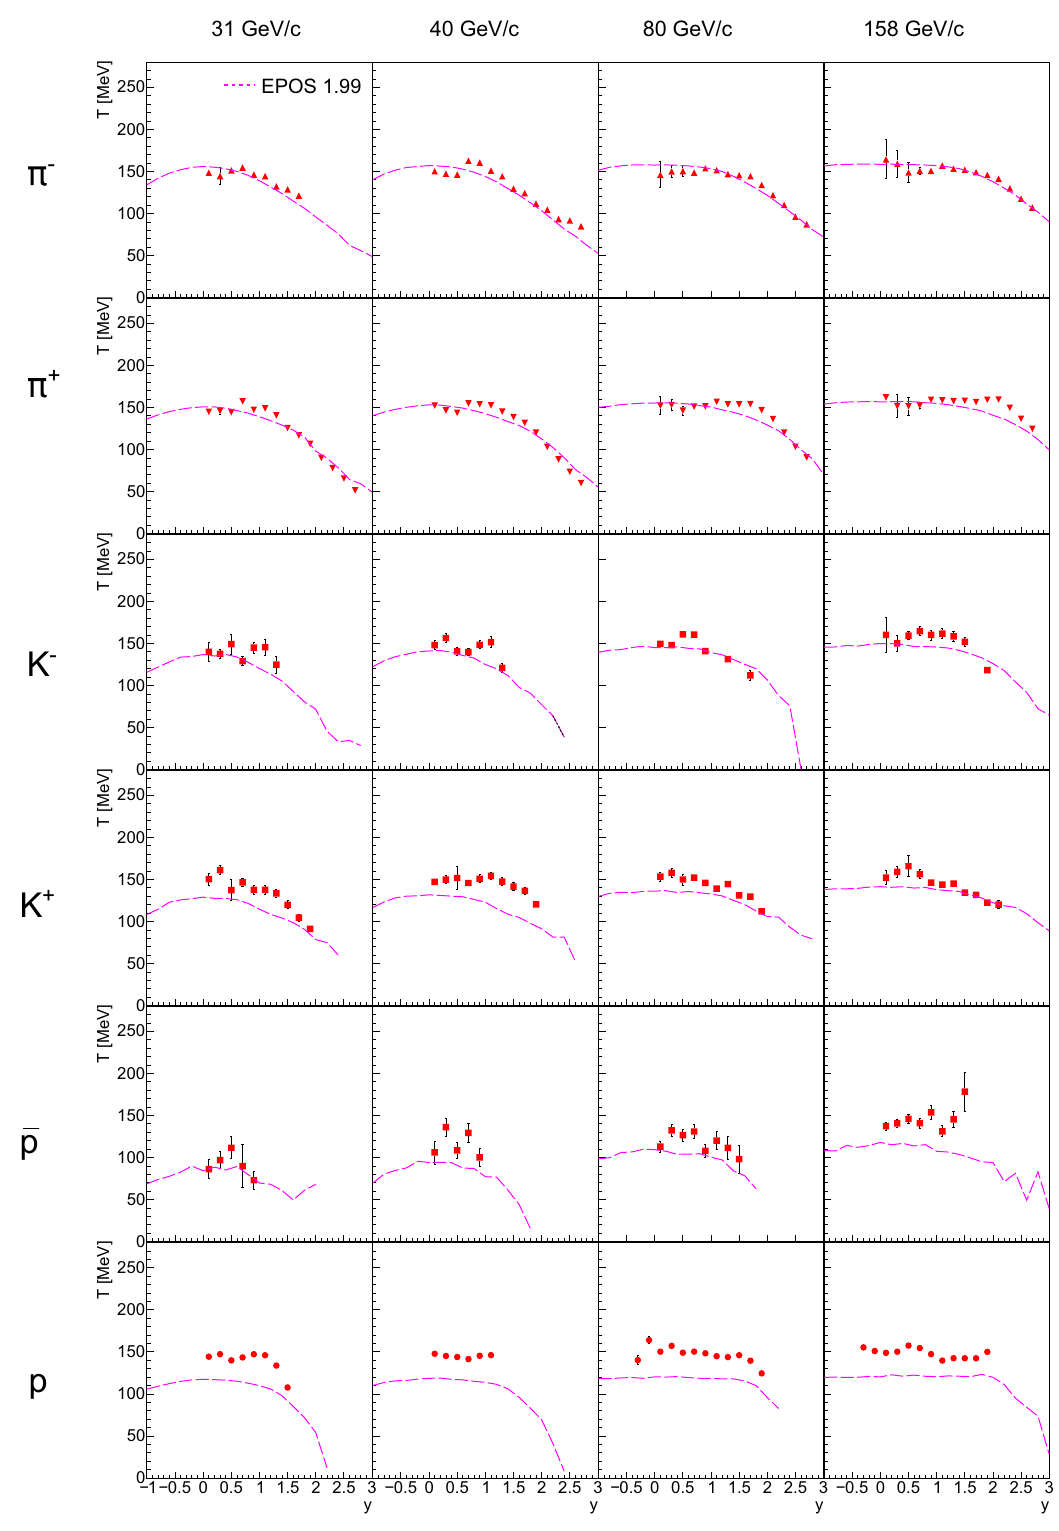
Fig. 33 Inverse slope parameter T obtained from fits with Eq. (19) to the p T distributions of K + , K − , π + , π − , p and ¯ p as function of rapidity in inelastic p + p collisions at 30, 40, 80 and 158 GeV / c . Results are